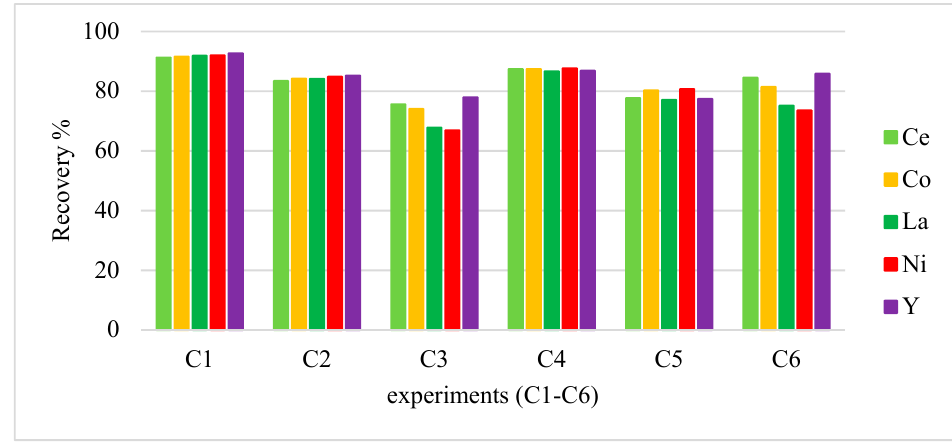
Figure 4. 2 mol/L acid anode leaching with mesh material (C series experiment).